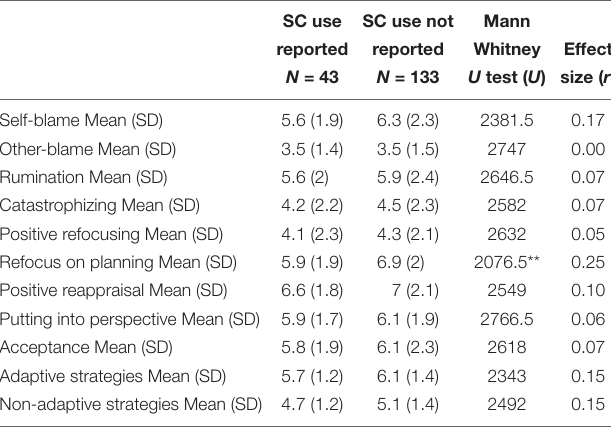
TABLE 4 | Cognitive emotion regulation related to stressful live events in SC and non-SC using